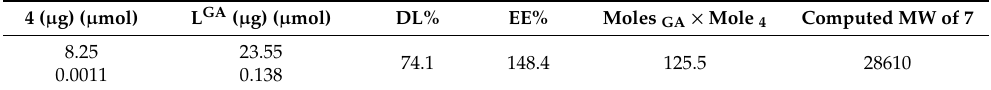
Table 1. GA’s average load (L GA ) in a sample of GALD 7 (31.8 µ g) expressed in µ g, as drug loading (DL%), entrapment e ffi ciency (EE%), and GA moles (moles GA ) loaded per dendrimer mole (mole 4 ), and computed Molecular Weight (MW) of GALD 7 . Values of A, C GA , and ε GAOxC obtained for the six aliquots of a 31.8 µ g / mL sample of GALD 7 .